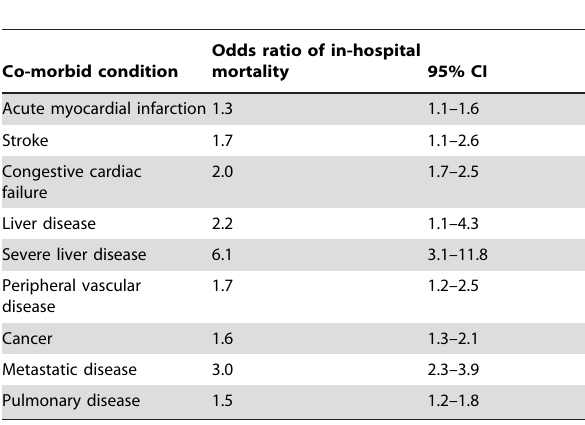
Table 4. Binary logistic regression model with in-hospital mortality as the dependent